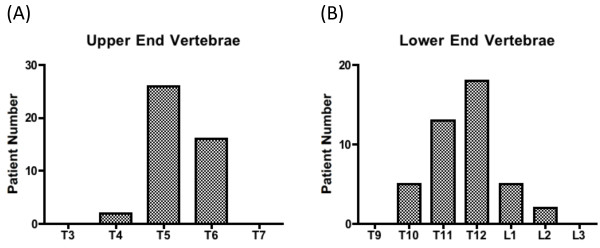
Range of curvature in scoliosis patients. The upper and lower end vertebrae were examined in scoliosis patients. The median of the upper end was at T5 and the lower end at T12. All were instances of right thoracic scoliosis.